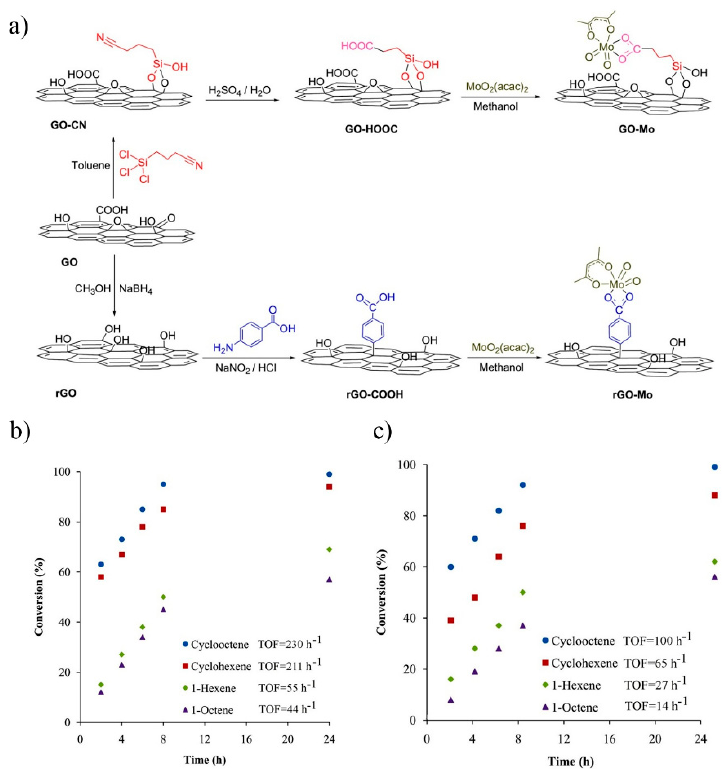
Figure 5. ( a ) Synthetic strategy of GO-Mo and rGO-Mo catalysts; ( b ) alkenes epoxidation procedure with rGO-Mo; ( c ) alkenes epoxidation procedure with GO-Mo. Reproduced with permission from reference [88]. Elsevier (2018).